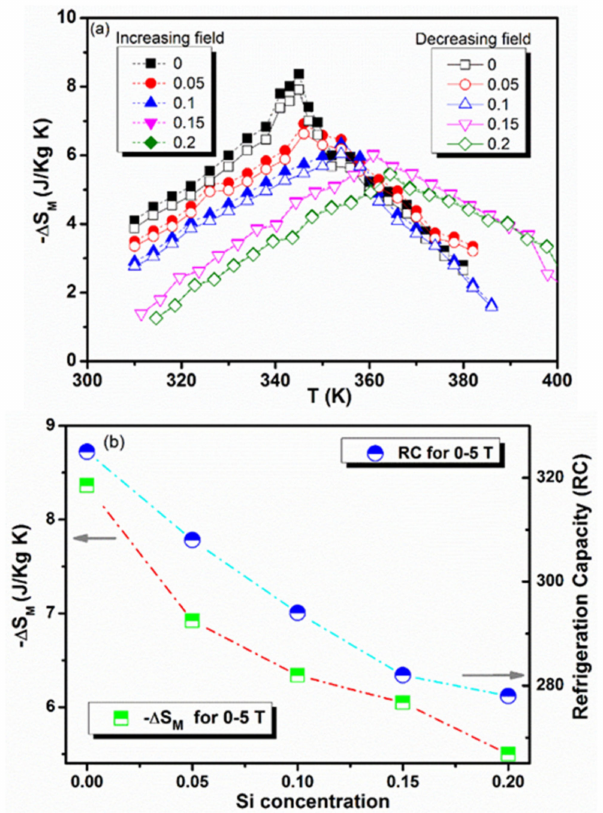
Figure 4. ( a ) Temperature dependence of the isothermal magnetic entropy change, − ∆ S M , ( T , H ) for MnCoGe 1 − x Si x compounds ( x = 0, 0.05, 0.10, 0.15, 0.20) calculated from magnetization isotherms with 0–5 T field change applied. Increasing fields are denoted by closed symbols, while decreasing fields are denoted by open symbols. ( b ) The RC and − ∆ S M of MnCoGe 1 − x Si x compounds for 0–5